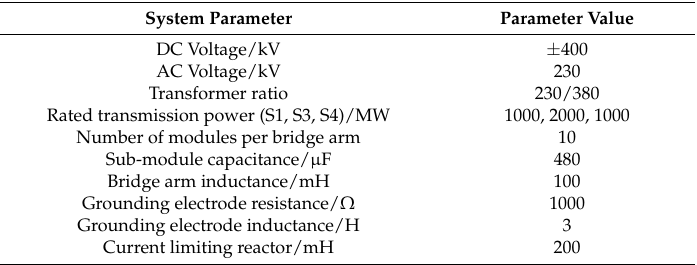
Table 1. Simulation parameters of the test model.